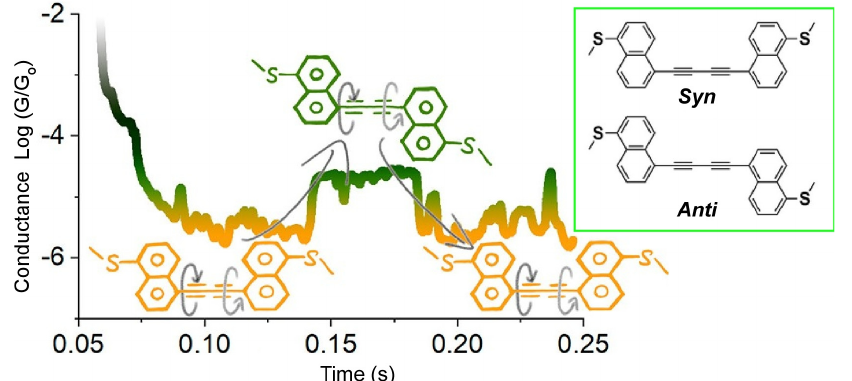
Figure 3. Single molecular conductance measurements for a cranked molecule, in which two naphthyl groups are free to rotate along the 1,3-butadinyl axis, to evaluate fluctuations corresponding to the syn- and anti-conformation change. Reprinted with permission from Reference [125]. Copyright 2021 American Chemical Society.